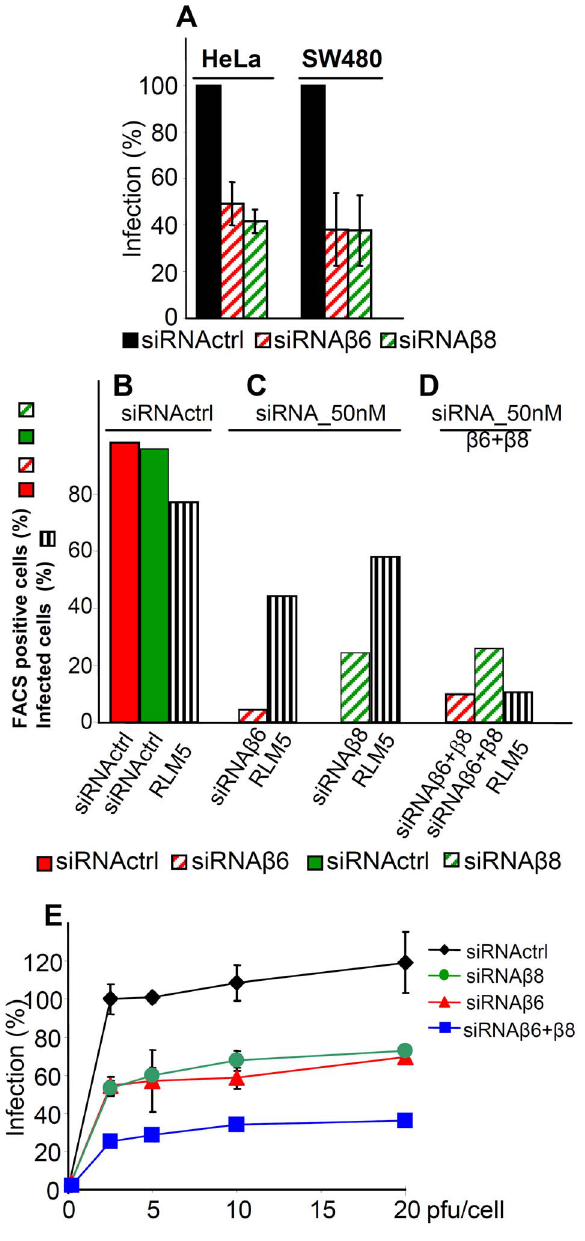
Figure 4. Inhibition of HSV-1 infection by silencing of b 6- or b 8- integrin. (A) Extent of R8102 infection in silenced cells was quantified as detailed legend to Fig. 3. 100% infection is the value obtained with siRNActrl cells. Values represent the average of quadruplicates. Bars show SD. (B–D) Red or green columns represent extent of b 6 or of b 8- integrin expression in 293 T cells, either mock-silenced (full columns), or silenced (hatched columns). Striped black columns represent extent infection with RLM5 as detected by FACS. (E) Inhibition of R8102 infection in 293T cells silenced with siRNActrl (black diamond), or with siRNA to b 6- (red triangle), b 8- (green circle), or b 6-plus b 8- (blue square) integrins. Cells were infected at increasing MOI (pfu/cell), and harvested at 16 h after infection, as detailed in the legend to Fig. 3. each point represents the average of triplicates 6 SD. doi:10.1371/journal.ppat.1003806.g004 DNA/well for nectin1 plasmid, 300 ng DNA/well each for a and for b integrin-subunits). It can be seen from Fig. 7 B that a v b 6- or a v b 8-integrin each doubled the efficiency of infection attained